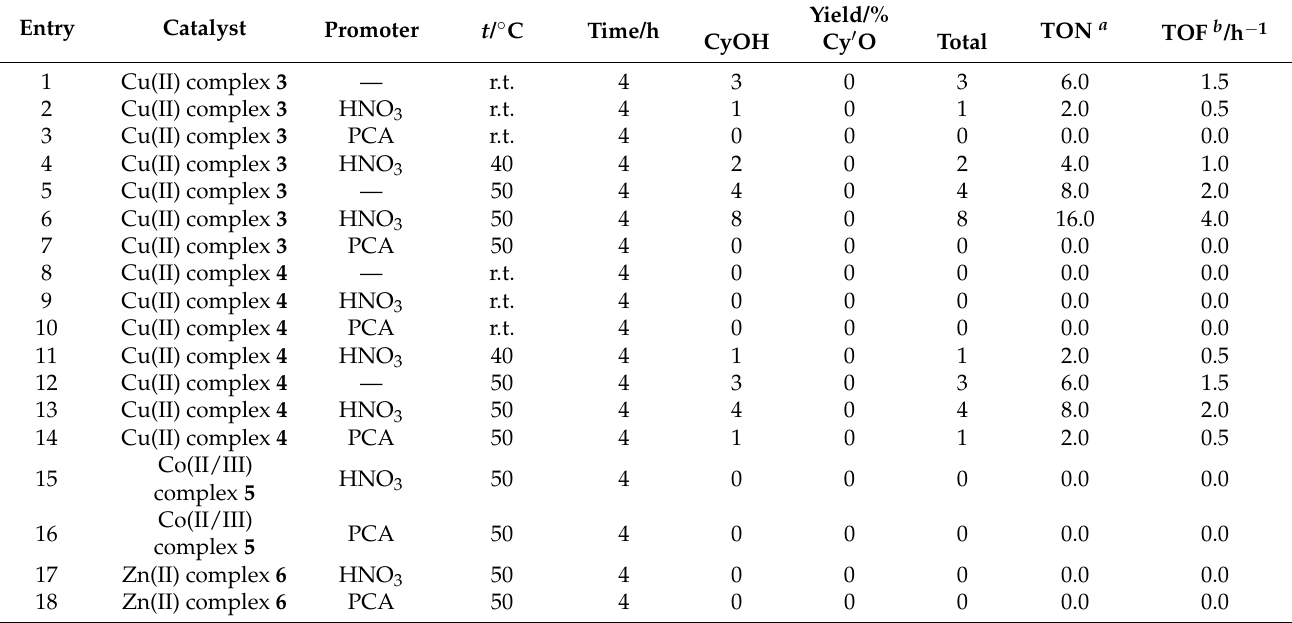
Table 3. Peroxidative oxidation of cyclohexane catalyzed by complexes 3 – 6